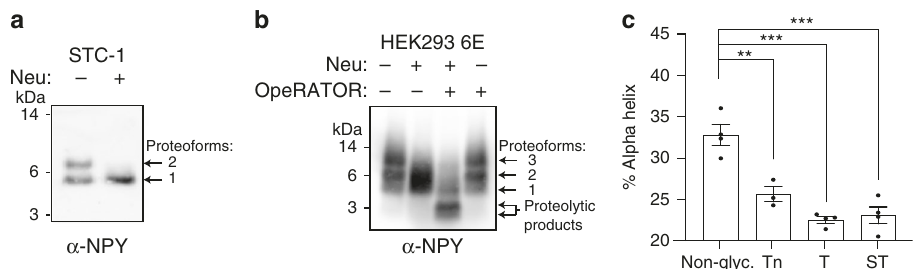
Fig. 5 Molecular and structural analysis of NPY and its precursor. a Western blot of conditioned media from STC-1 cells stably expressing proNPY using an antibody recognizing pro- and mature NPY. The conditioned media from proNPY-transfected STC-1 cells was concentrated using TCA precipitation, and analyzed with and without neuraminidase treatment (Neu). b Western blot of conditioned media from proNPY-transfected HEK293-6E cells were analyzed with and without neuraminidase treatment (Neu), OpeRATOR treatment, or both in combination. Both western blot experiments in a and b were repeated three times with similar results. c Alpha-helical content of 20 µ M NPY or its glycoforms determined by CD spectroscopy (pH 7 at 25 °C) ( n = 4 independent measurements for all groups except Tn where n = 3). All error bars represent mean ± S.E.M. Two-tailed one-way ANOVA (Tukey ’ s post hoc test) was performed in c . *** p < 0.001, ** p < 0.01 (all p -values are <0.0001 except c Non-glyc/Tn where p = 0.0018). Source data for a – c are provided as